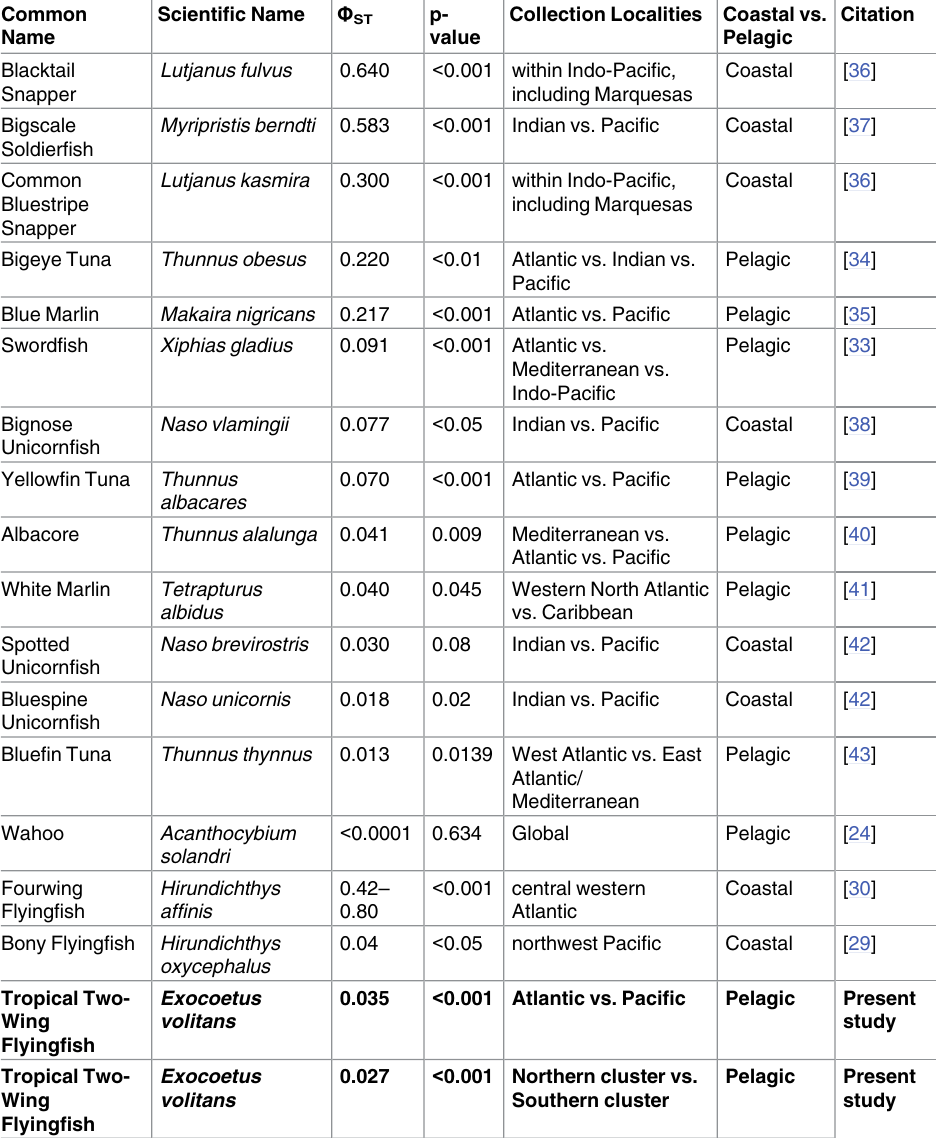
Table 4. Comparison of Φ ST values from population genetic studies involving widely distributed marine teleosts including Exocoetus volitans (results of present study in bold), and two other flying- fish species ( Hirundichthys affinis , and H . oxycephalus ) for which a Φ ST estimatesare